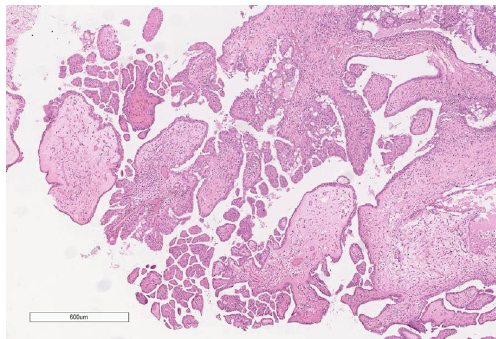
Figure 3: Hierarchical papillae with stroma of edematous appearance. 5x HyE. fi ndings. In addition, a karyotype of fi fty metaphases was analyzed with normal results (46, XY).